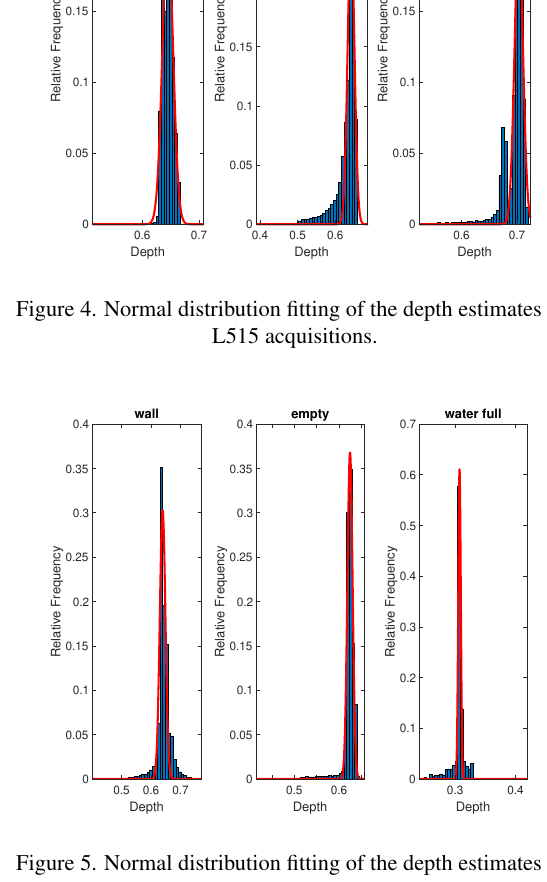
Figure 5. Normal distribution fitting of the depth estimates for SR305 acquisitions.